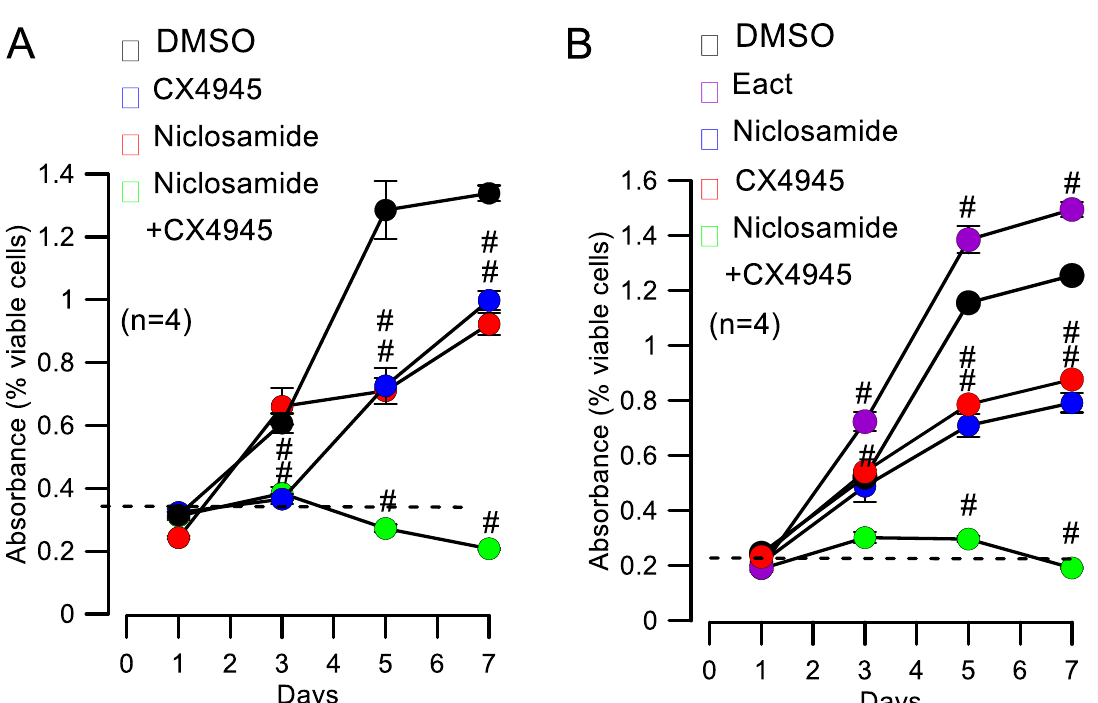
Figure 5. Blockers of CK2 and TMEM16A inhibit proliferation of Cal33 and BHY head and neck cancer cells. ( A ) Blocking CK2 by CX4945 (20 µM) and blocking TMEM16A by niclosamide (0.5 µM) inhibited proliferation of Cal33 cells. Simultaneous application of both blockers had an additive effect (#significant inhibition, unpaired t-tests; p = 0.0001). ( B ) Enhanced cell proliferation of BHY cells induced by the TMEM16A-activator, Eact. Blocking CK2 by CX4945 (20 µM) and blocking TMEM16A by niclosamide (0.5 µM) inhibited proliferation of BHY cells. Simultaneous application of both blockers had an additive effect (#significant inhibition, unpaired t-tests; p = 0.000015). Mean ± SEM. In parentheses are numbers of experiments.